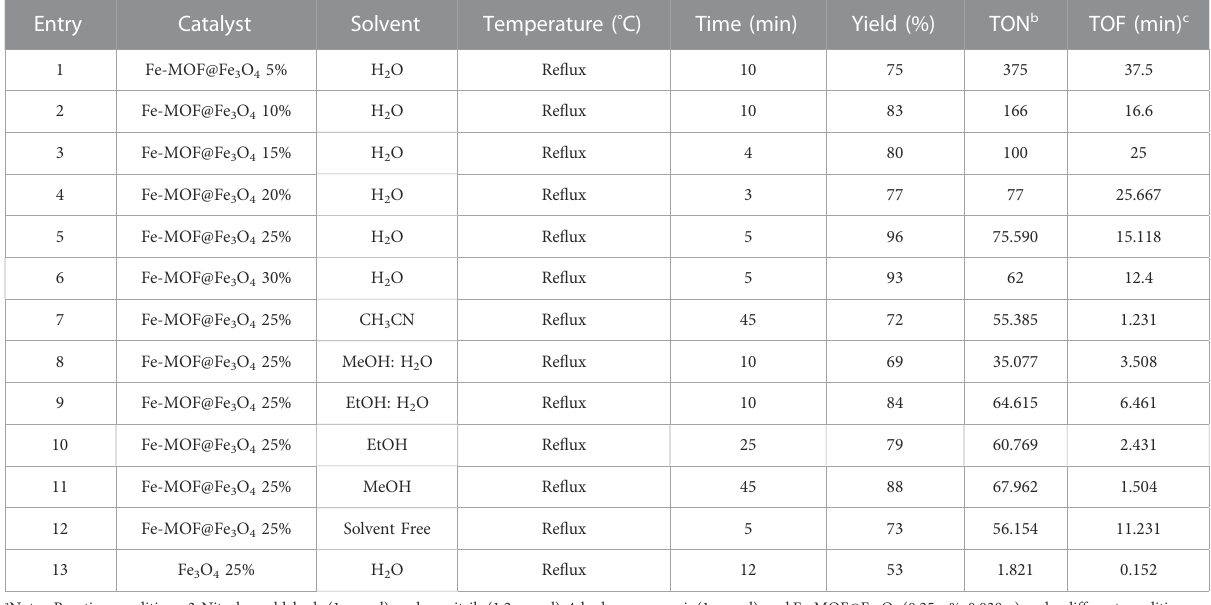
(Figure 1A) with identical dimensions and morphologies. A closer examination showed that each nano fl ower was composed of three petals and anthers (Figure 1B). The petals exhibited a wall structure with a thickness of ~ 100 nm. Moreover, the smooth surface of the petals showed regular trigonal shapes.